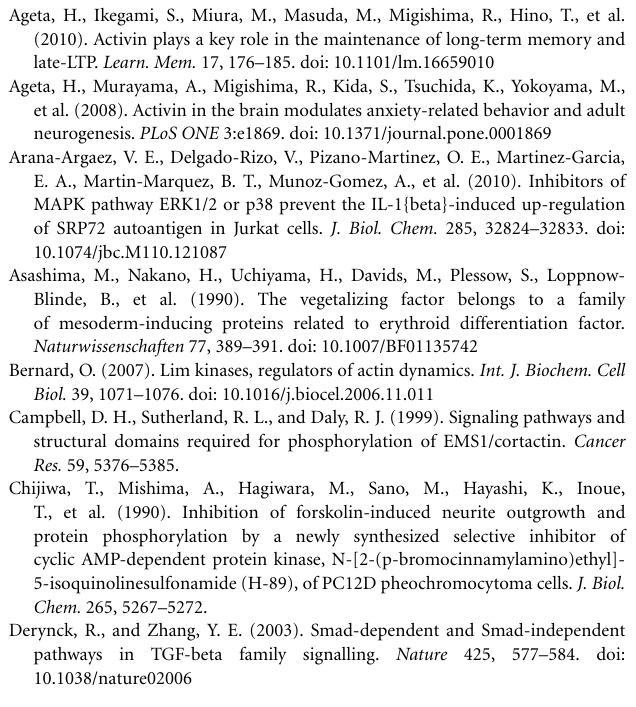
Figure S1 | (A) Western blot of activin receptor and activin. ActR, activin receptor. (B) Act, activin; Marker, protein marker. Anti-activin antiserum recognized the main band of 13kDa activin